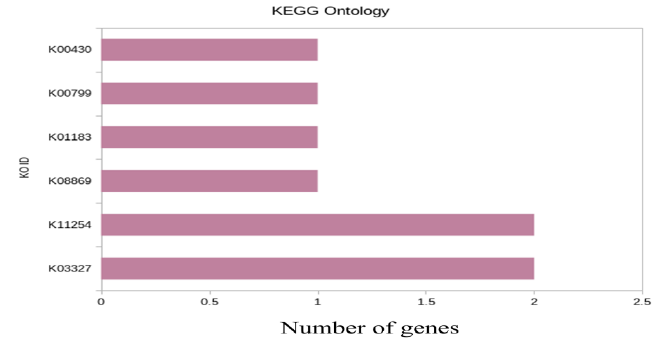
Figure 4. Bar plot of enriched pathway of the significant genes. In WH-1184, significant genes (upregulated), K03327 (TraesCS3B02G068700/TraesCS7A02G357000) located on 3B/7A chromosomes, encoded Protein detoxification (Multidrug and toxic compound extrusion protein) and K11254 (TraesCS6B02G288000/TraesCSU02G175900), encoded uncharacterized protein had